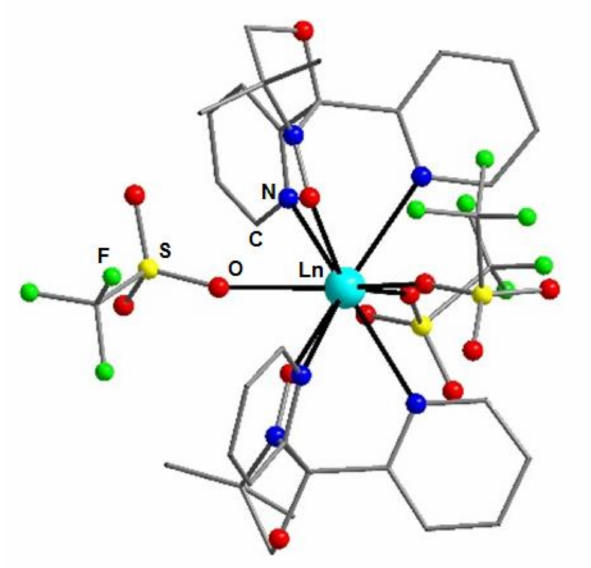
Figure 1. Structure of molecules 1 and 2 . Hydrogen atoms are not shown.